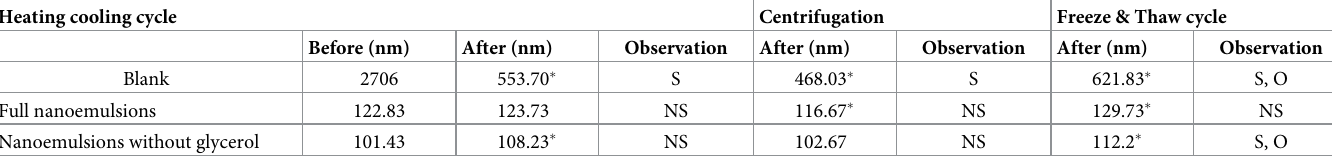
Table 1. Thermodynamic stability studies of